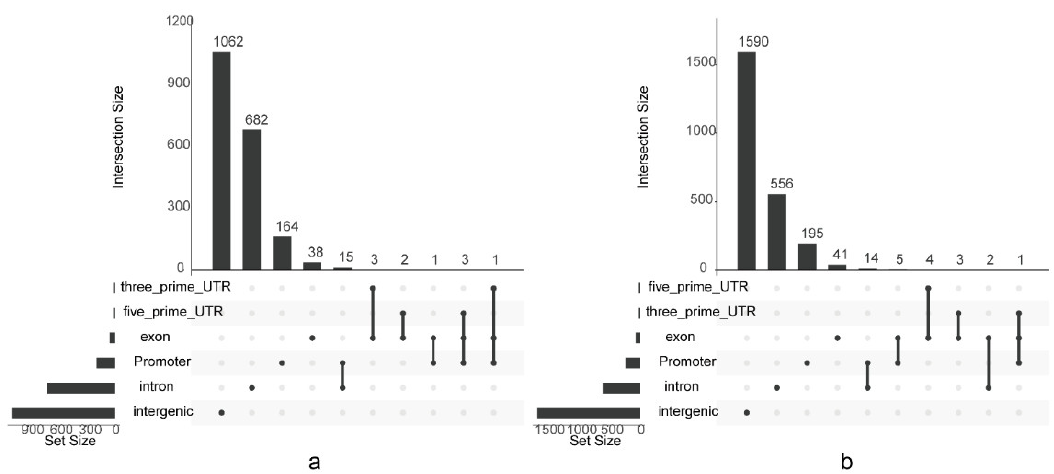
Figure 7. Distribution of differential peaks among the sheep genomes. ( a ) Up-regulated peaks; ( b ) down-regulated peaks. According to the genome coordinates of detected peaks, peaks can be divided into six categories, including in intergenic region, intron region, promoter region, exon region, 3′ untranslated region (UTR) and 5′ untranslated region. Dots in the bottom denote the peak categories. Black lines connecting the dots show peak numbers shared among several categories. The number above each bar shows the number of peaks for each category or shared category.